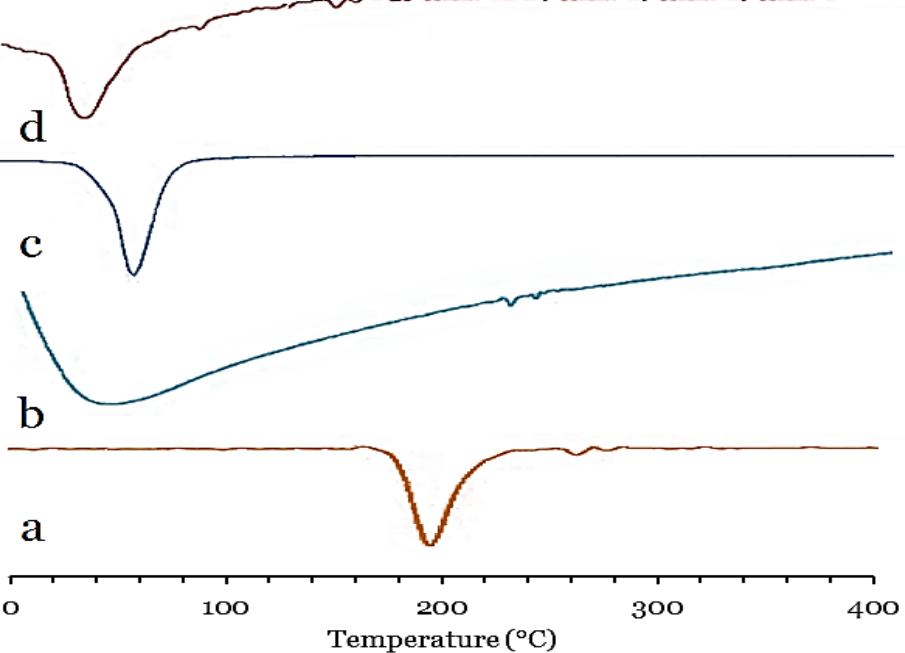
Figure 2. DSC thermograms of ( a ) pure GFT, ( b ) GMO, ( c ) P407, and ( d ) optimized GFT‑CNP for‑ mulation (GC9).